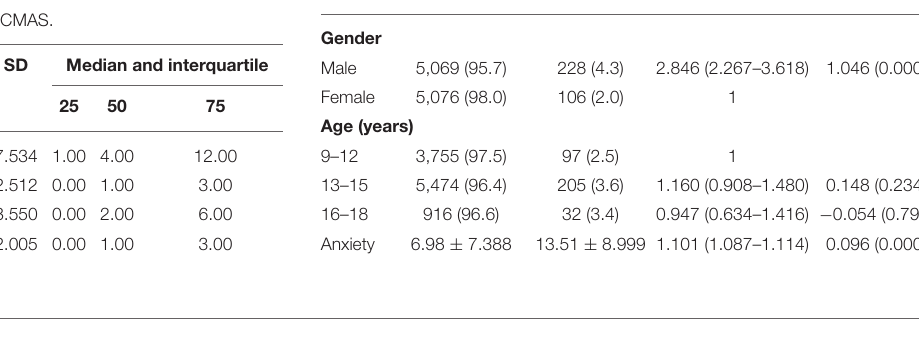
TABLE 4 | Anxiety scores by IGD group.